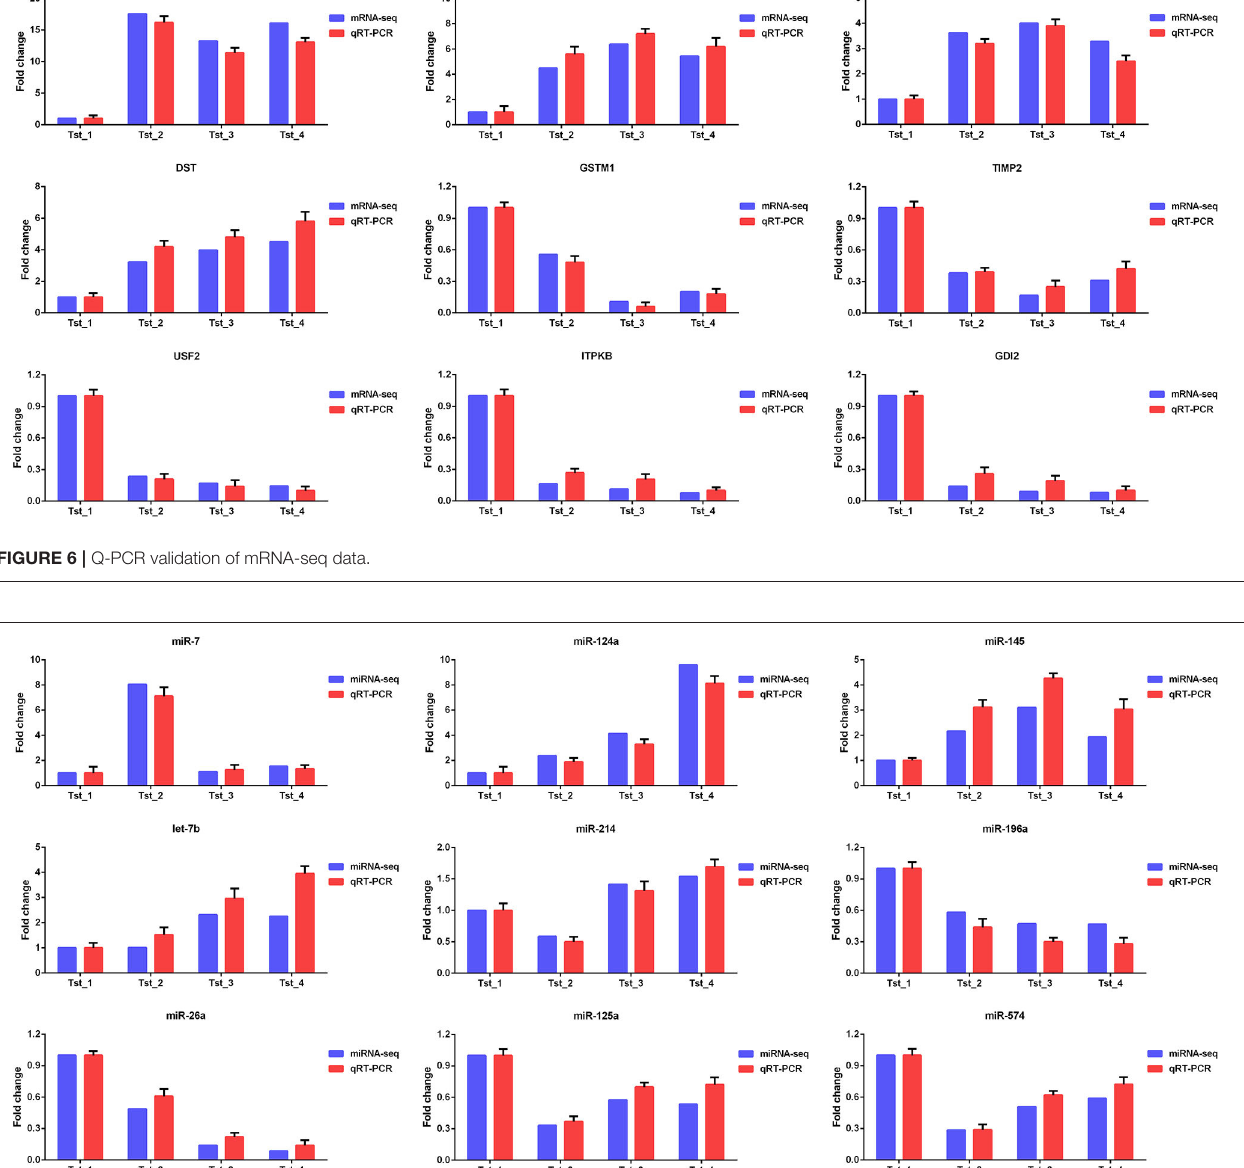
FIGURE 7 | Q-PCR validation of miRNA-seq